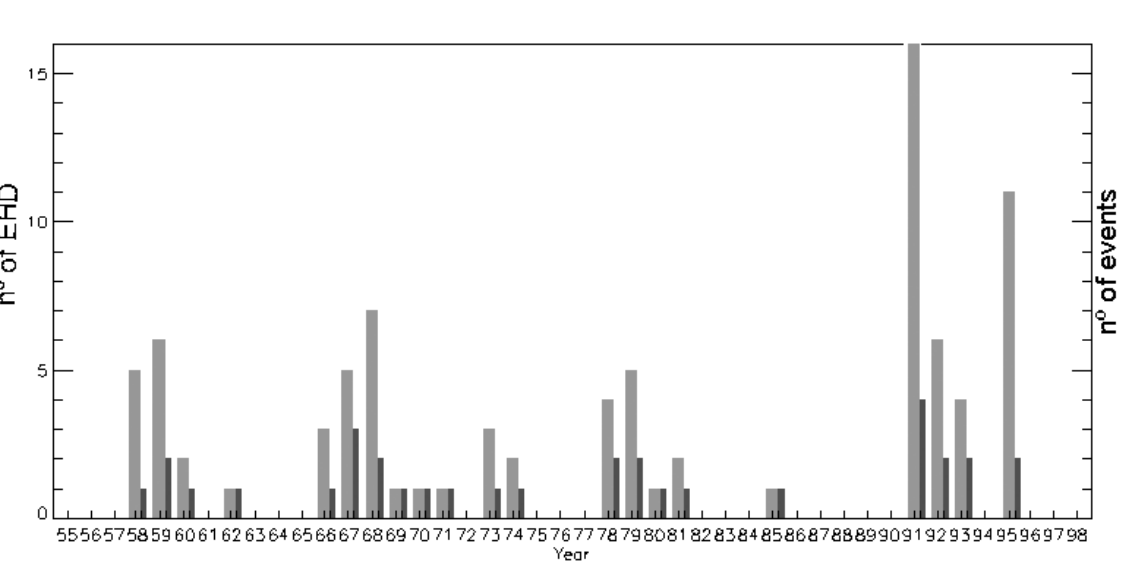
Fig. 8. Similar to Fig. 7, but for the analyzed wind at 850hPa.